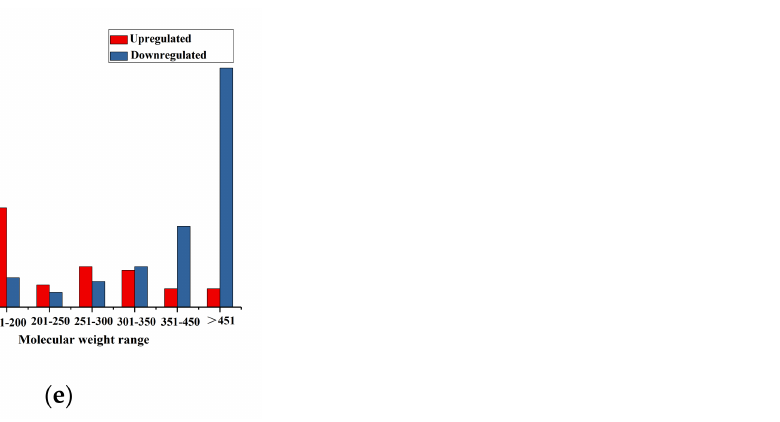
Figure 4. Differentially accumulated metabolites between AC and FAC. ( a ) Score scatter plot of the OPLS-DA model; ( b ) permutation test of the OPLS-DA model; ( c ) volcano plot of the differential metabolites; ( d ) classification of differentially expressed metabolites; ( e ) molecular weight range of differential phenolic acids and